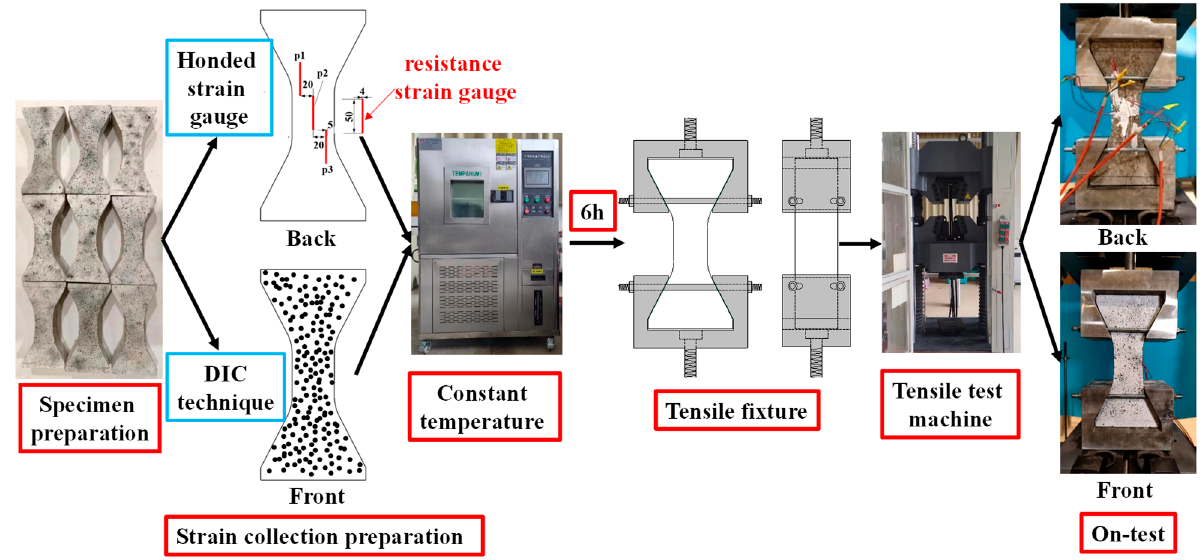
Figure 8. Experimental